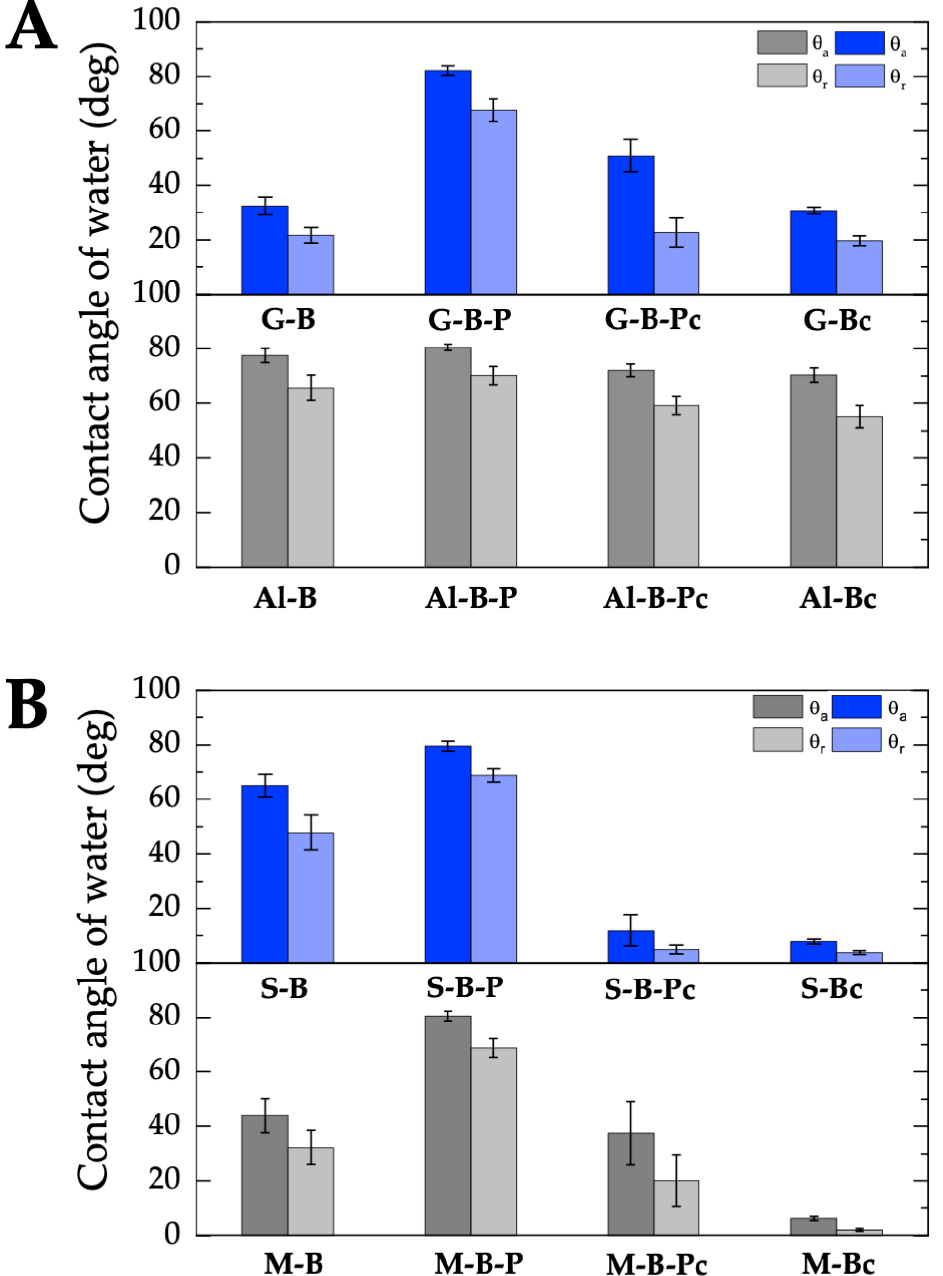
Figure 6. Advancing and receding contact angles of water on the bare sensitive surfaces, covered with paint, after the removal of the paint coating with NE No. 10, and after cleaning the bare surface with NE No. 10. ( A ) Surfaces from the man-made materials. ( B ) Surfaces from the natural materials. The type of material, its surface treatment, the surface roughness, and its hydropho- bic/hydrophilic properties determine the wettability of the surface with water [24,61]. The smallest water contact angles on the bare plates were obtained on the glass surface (G-B) which is the smoothest of all the tested bare materials. The reproducibility of the advanc- ing and receding contact angle values was very good (vertical bars show standard devia- tions). The glass surface, the main component of which is SiO 2 , is preferentially wetted by water because of its hydrophilic character due to the presence of hydroxyl groups and siloxane bridges. The hydroxyl (silanol) groups represent strong adsorption sites that in- teract specifically with water molecules by hydrogen bonding. Water is a polar liquid with a surface tension of 72.8 mN/m at 20 °C whose apolar component is 21.8 mN/m and polar one is 51 mN/m. Hence, the interactions across the water–solid interface are of a dispersive nature and exhibit a polar acid–base character (electron–donor and electron–acceptor). Strong intermolecular interactions occurring at the nanoscale usually lead to